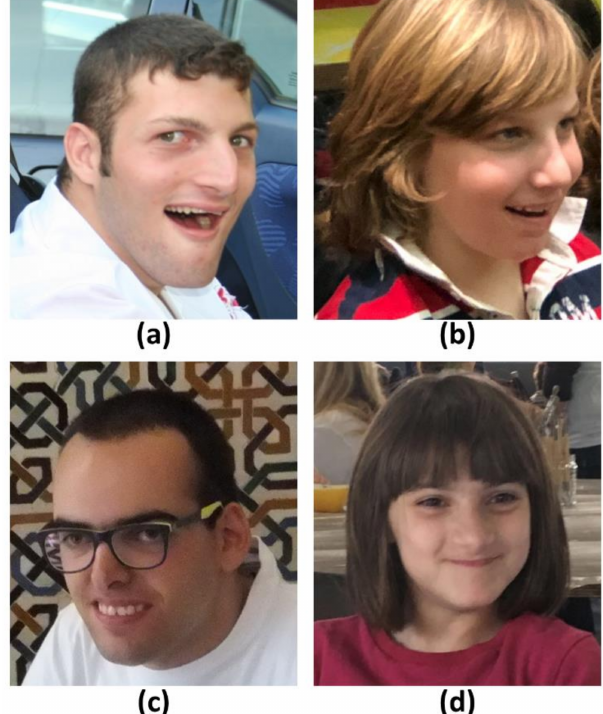
Figure 1. A photograph of AS patients representative of the genetic mechanisms: ( a ) deletion of 15q11–12; ( b ) chr.15 paternal uniparental disomy; ( c ) imprinting centre; ( d ) UBE3A point mutations. All patients’ parents have signed the informed